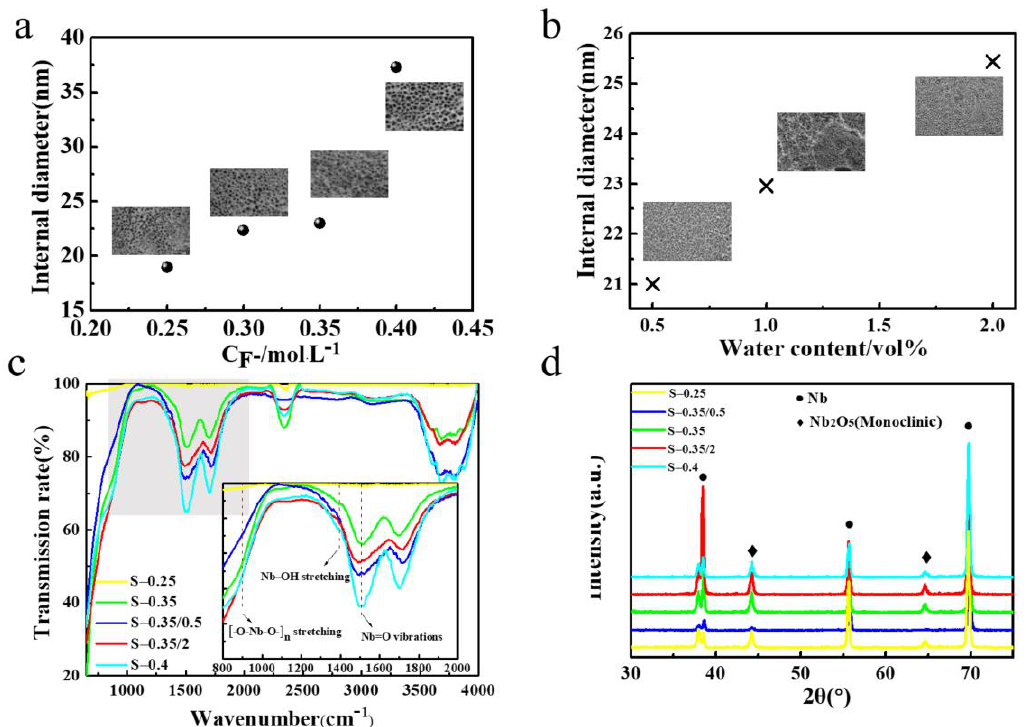
Figure 5. High-resolution SEM images and corresponding internal diameters of anodic oxide layers formed by anodization of Nb foils at 20 V in ethylene glycol electrolytes with ( a ) concentration of NH 4 F, ( b ) water content, ( c ) ATR-IR spectra, and ( d ) XRD patterns of samples prepared under different conditions. Preparation conditions: Oxidized at 20 V in 2 h; samples S-0.25, S-0.35, and S-0.4 were prepared in electrolytes only containing ethylene glycol with fluoride ion concentration at 0.25, 0.35, and 0.4 M NH 4 F; samples S-0.35/0.5 and S-0.35/2 were formed with water content in 0.35 M NH 4 F at 0.5 and 2 vol%, respectively.